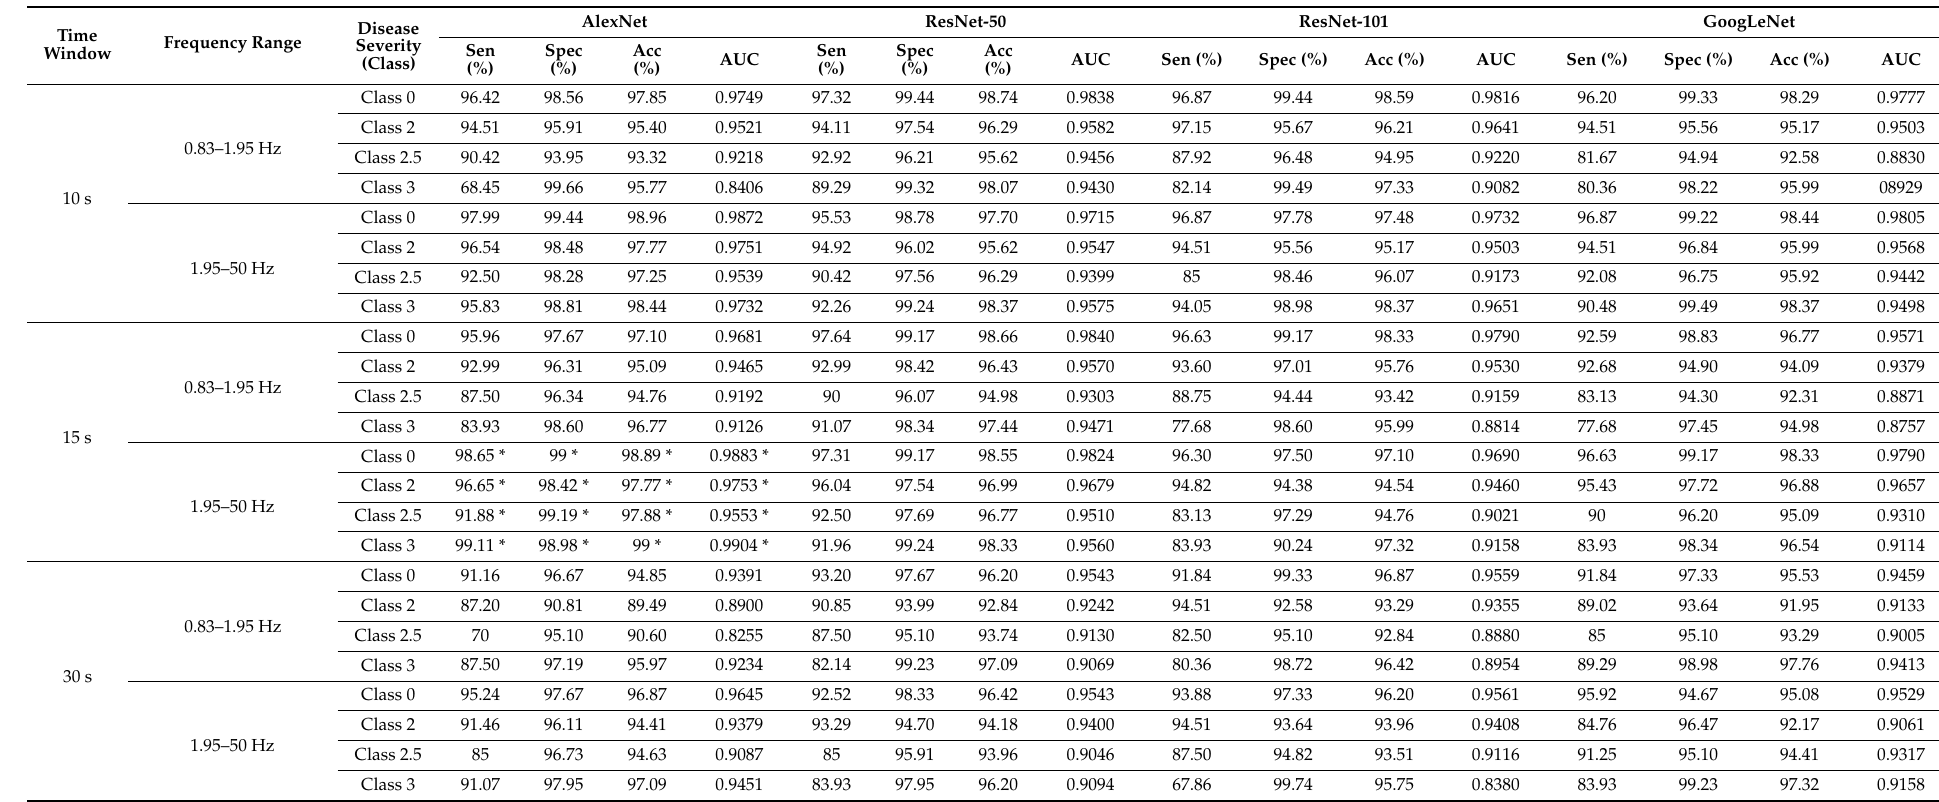
Table 11. Multi-class classification of CF Ga Dataset for CO (Class 0), PD Stage 2 (Class 2), PD Stage 2.5 (Class 2.5), and PD Stage 3 (Class 3) using several CNN classifiers (AlexNet, ResNet-50, ResNet-101, and GoogLeNet) with 10-fold